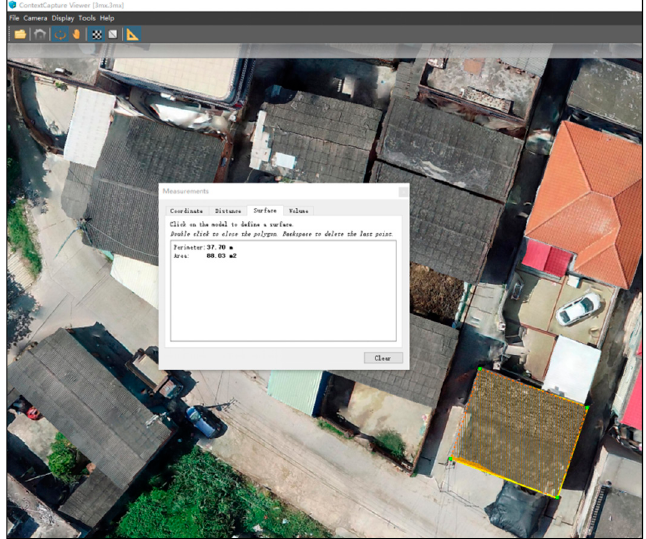
Figure 7. Building measurement based on 3D model.